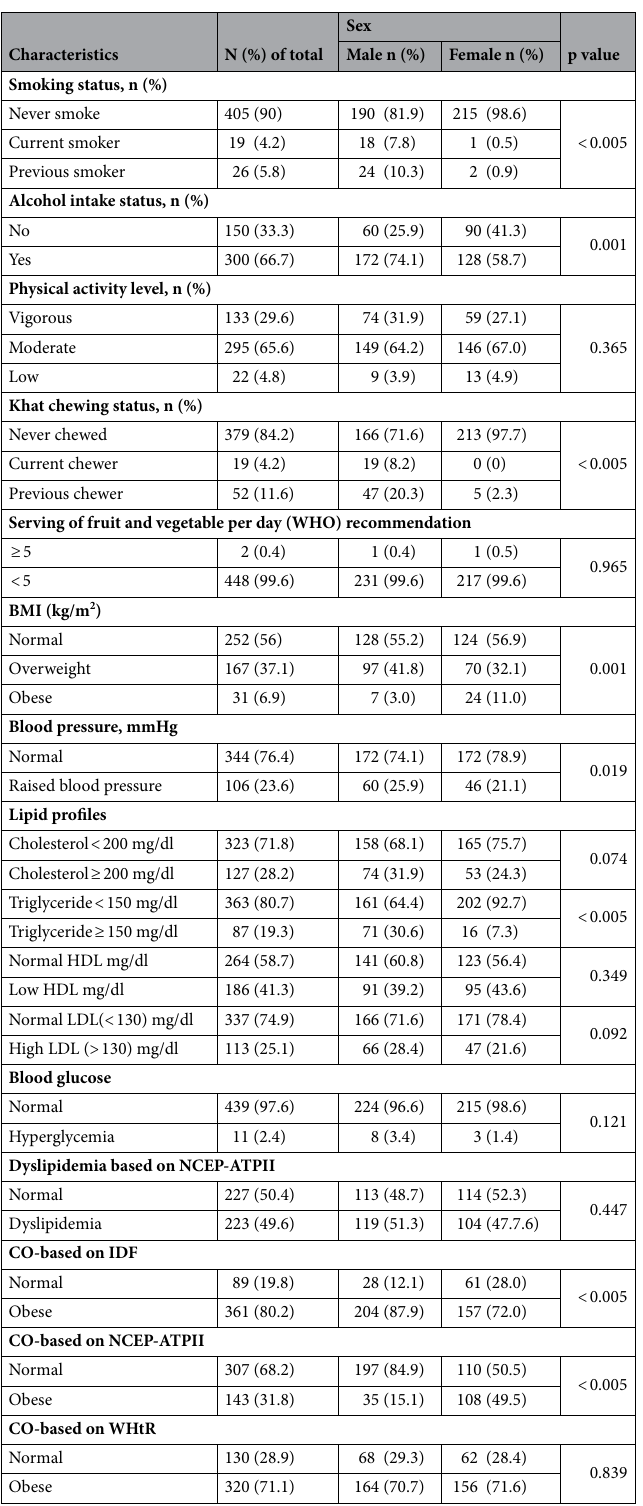
Table 3. Prevalence of behavioural clinical and biological characteristics of the study participant, EPHI, Addis Ababa, Ethiopia, 2018 (n = 450). * BMI body mass index, raised blood pressure (SBP ≥ 140